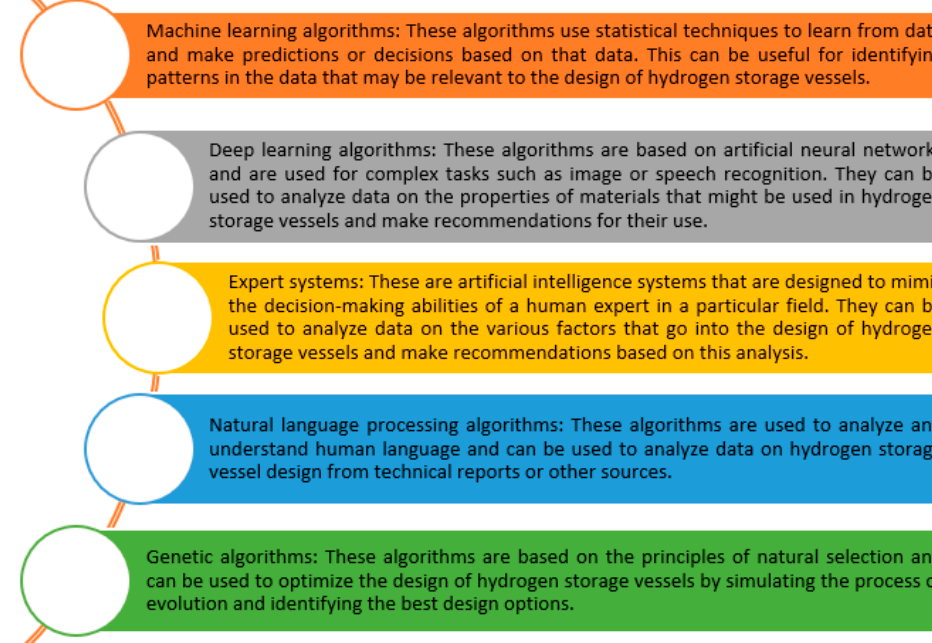
Figure 27. Types of artificial intelligence models used for the design of hydrogen storage vessels.